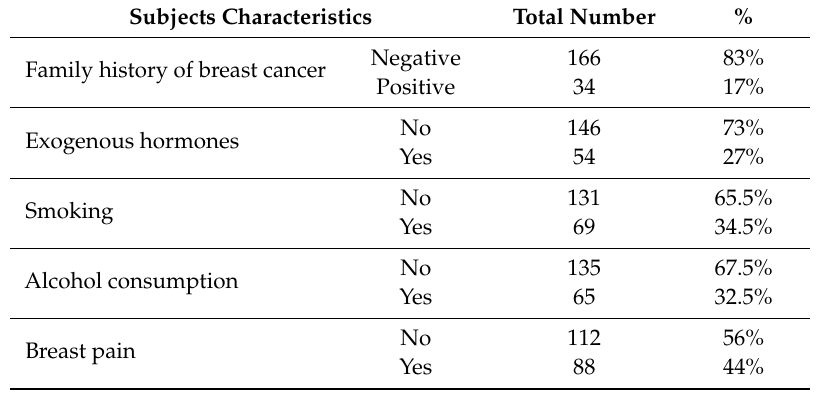
Table 1. Socio-demographic and clinical characteristics of participants involved in the